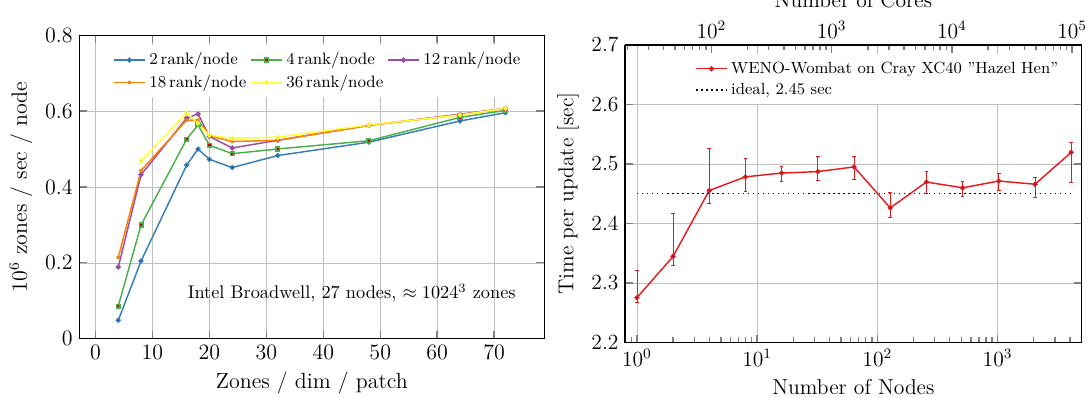
Figure 5. Left : Performance in Millions of zones per second per node for different patch sizes on 27 nodes with Intel Broadwell CPUs for a problem of approximate 1024 3 zones. Right : Weak scaling on the Cray XC40 “Hazel Hen” at HLRS Stuttgart, Germany. Shown is the mean time per update of 100 updates over the number of nodes/cores. Error bars indicate the largest and smallest timestep of 100, variations are due to node variablity of the shared